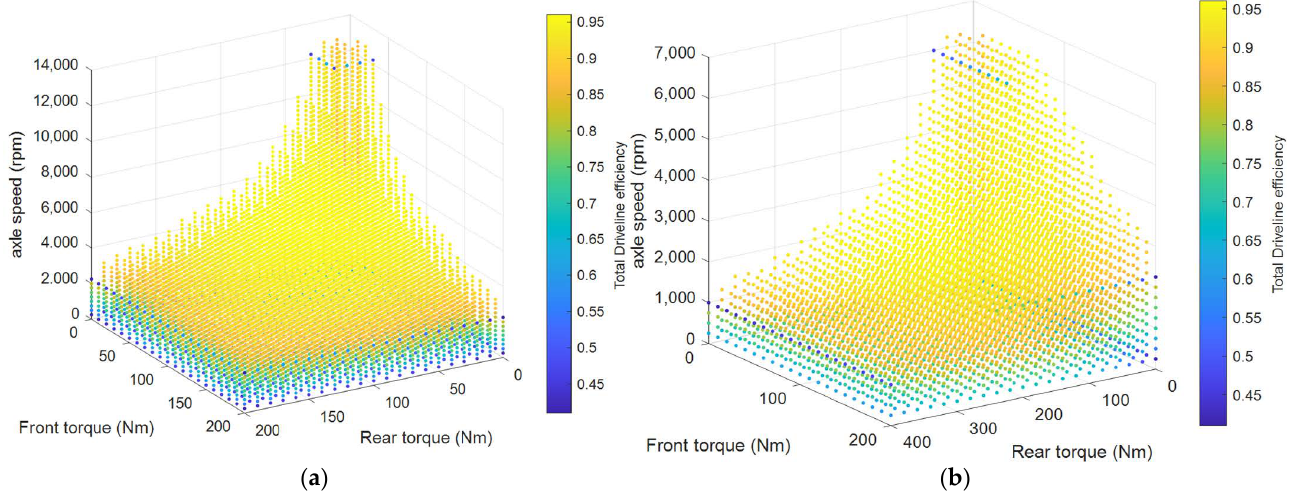
Figure 7. TMS map visualization according to gear ratio: ( a ) Front and rear reduction ratio 1:1, ( b ) Front reduction ratio 1:1, rear reduction ratio 2:1.